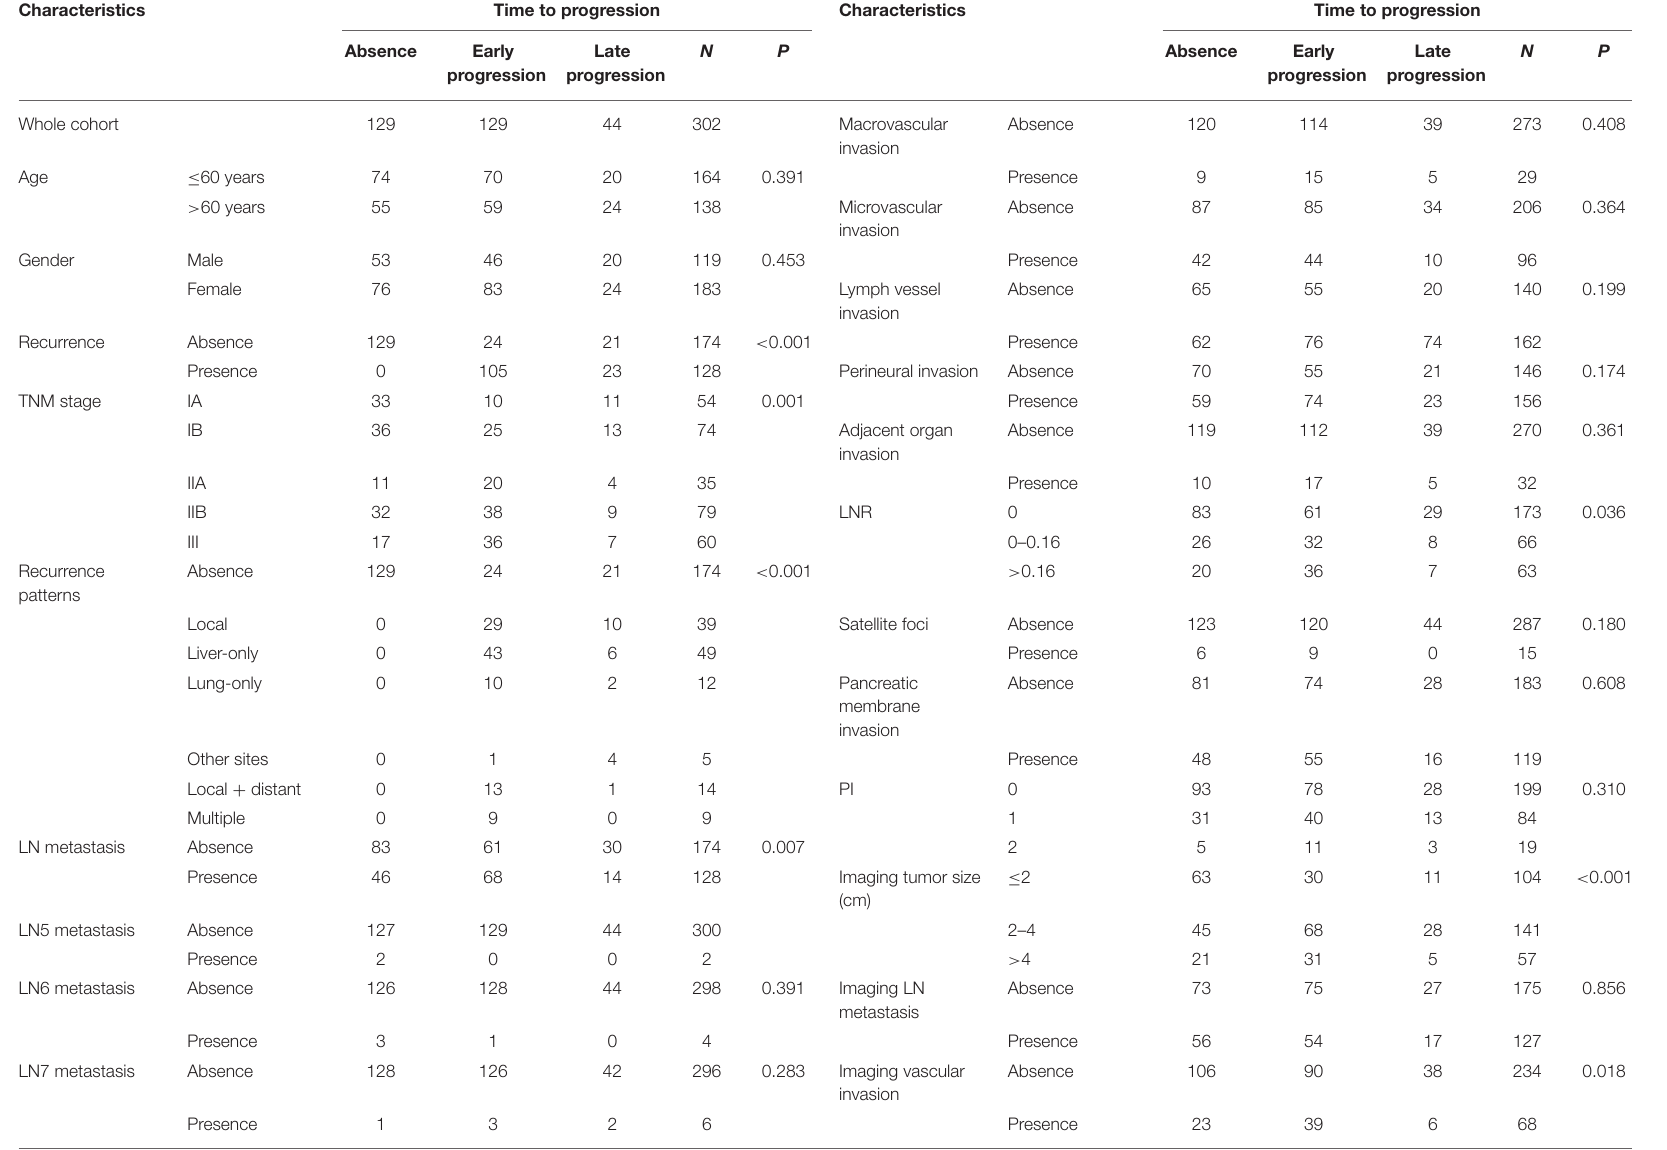
TABLE 1 | Clinicopathological characteristics of patients with